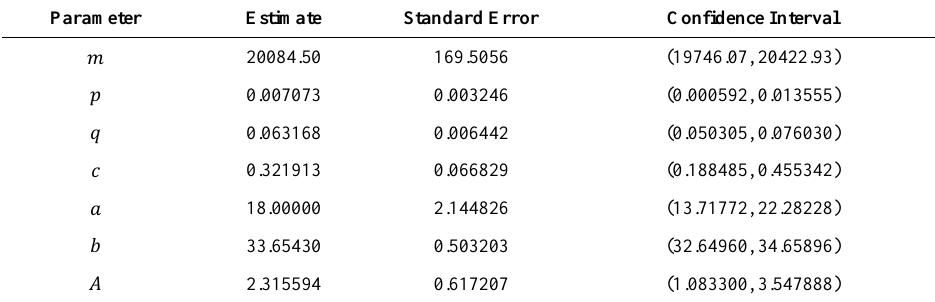
Table A3. Veneto. Estimates, asymptotic standard errors and 95% mCIs for the parameters of the BeGBM 𝑹𝑬𝑪𝑻 (7)+(5). Parameter